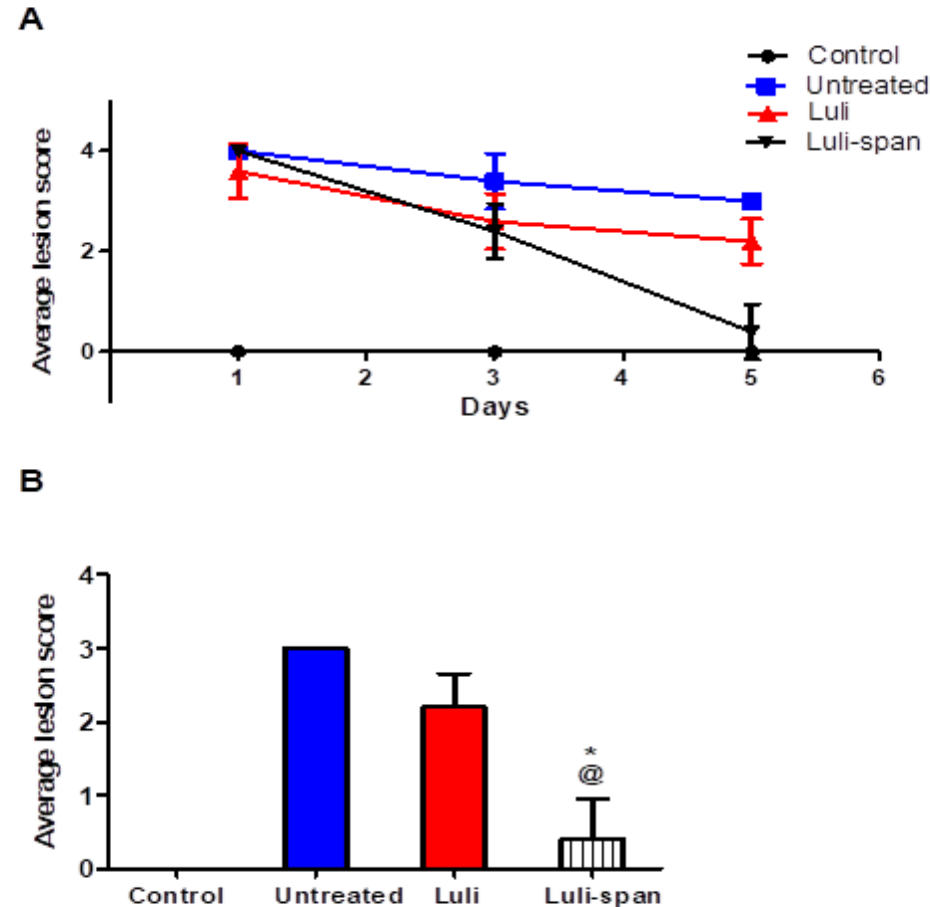
Figure 4. Establishment of infection expressed as lesion score after starting treatment in cutaneous candidiasis mouse model. Mice ( n = 5/group) were applied topically with luliconazole 25 mg/kg/day as Luli group and equivalent dose of luliconazole spanlastics (Luli-span group) for 5 days. ( A ) The score of erythema were measured on days 1, 3 and 5. ( B ) Average lesion score in C. albicans induced cutaneous candidiasis in mice treated with different formulations and compared with control and untreated group on the 5th day. Data were presented as mean ± SD. @ significant Luli span vs. untreated ( p < 0.0001). * Significant Luli span vs. Luli group ( p < 0.0001) determined by student t test.